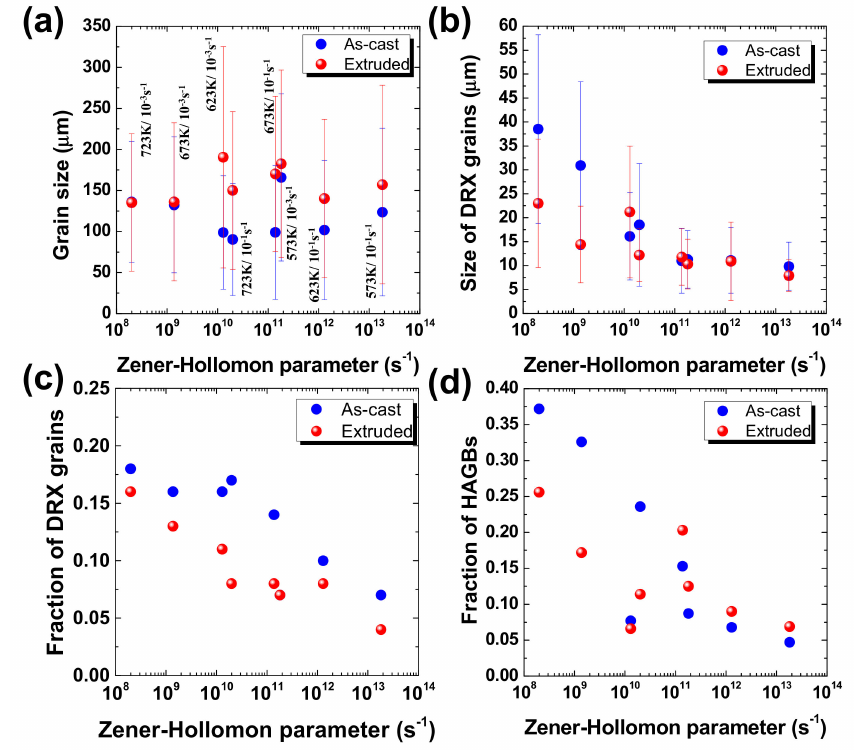
Figure 8. The ( a ) average grain size, ( b ) dynamically recrystallized grain size, ( c ) fraction of dynamically recrystallized grains and ( d ) fraction of high-angle grain boundaries determined from the EBSD analysis, which are plotted as a function of the Zener–Hollomon